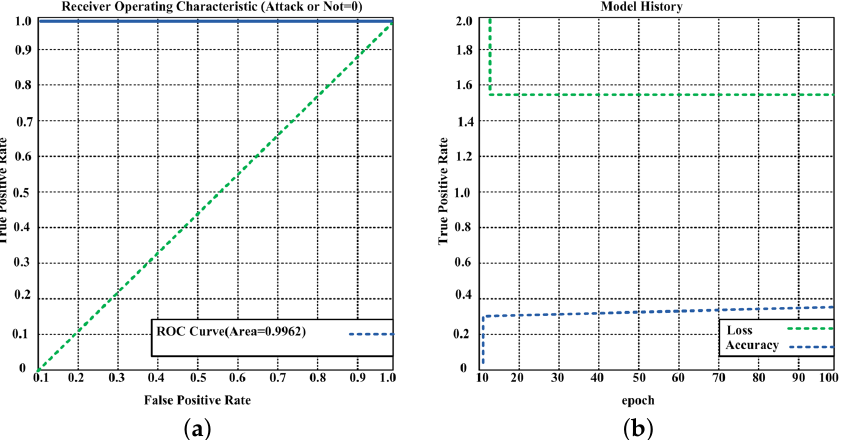
Figure 7. ( a ) ROC curve of the classification model. ( b ) Neural network model